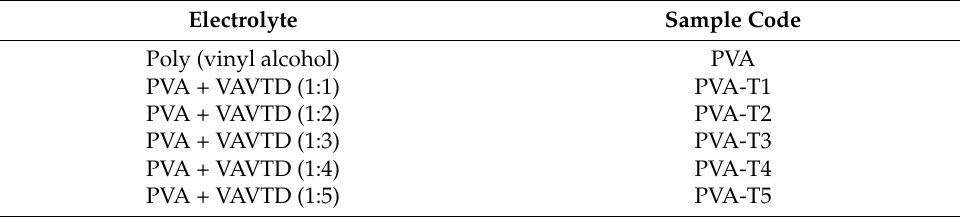
Table 3. Sample code of polymer electrolytes used in this